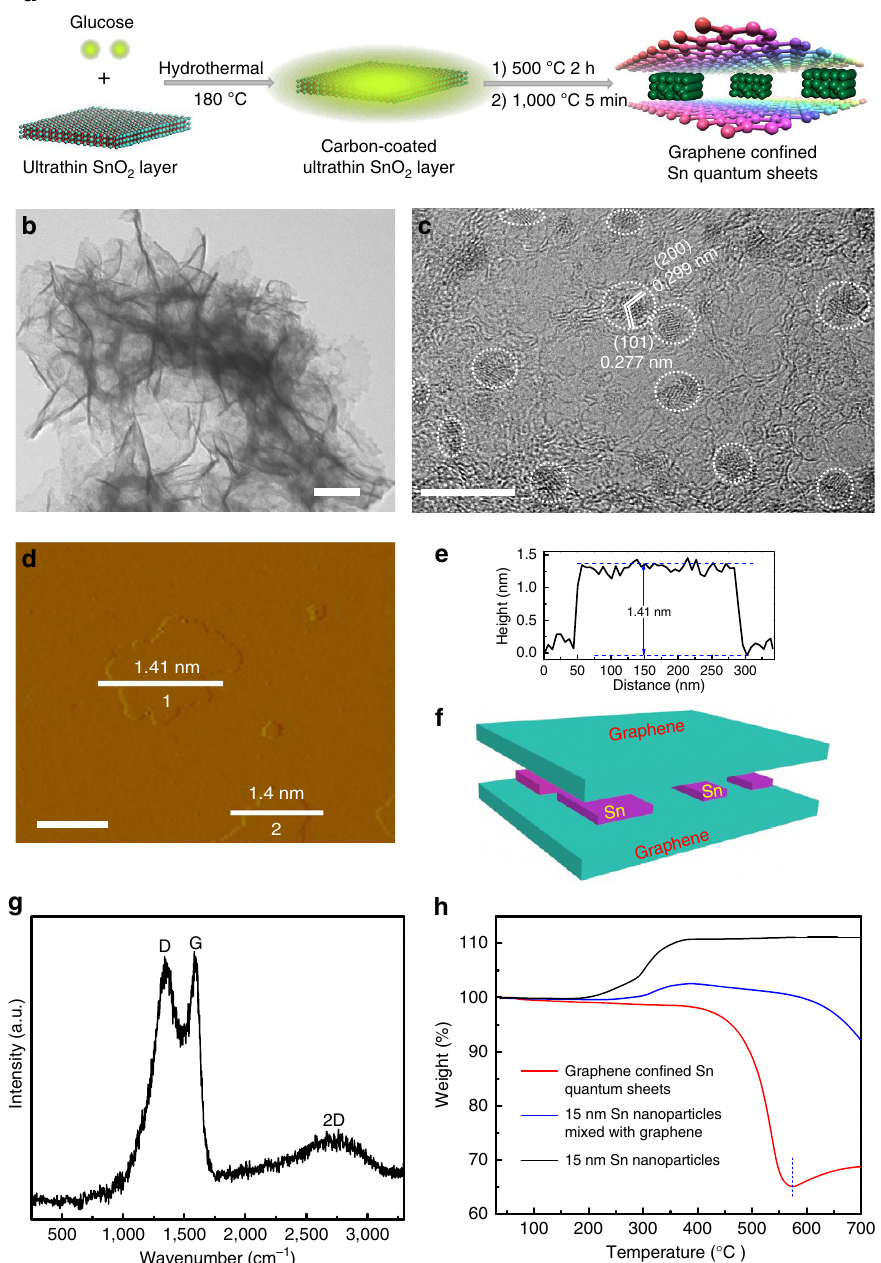
Figure 2 | Formation process and characterizations of the Sn quantum sheets confined in graphene. ( a ) Scheme illustration for the formation of Sn quantum sheets confined in graphene, ( b ) TEM image, ( c ) HRTEM image, ( d – f ) AFM image, the corresponding height profile and scheme illustration and ( g ) micro-Raman spectrum of the Sn quantum sheets confined in graphene. ( h ) TG analysis of Sn quantum sheets confined in graphene, 15nm Sn nanoparticles and 15nm Sn nanoparticles mixed with graphene. The scale bars in ( b – d ) are 100, 10 and 200nm, respectively. The inset circles in ( c ) denote the presence of Sn quantum